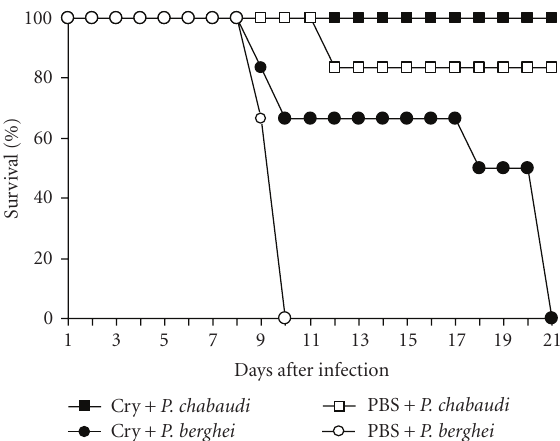
Figure 2: E ff ect of Cry1Ac on the survival of Plasmodium -infected mice. Cry1Ac pretreated mice ( n = 8) were infected with P. chabaudi AS or P. berghei ANKA. Survival was recorded until day 21 PI, at which time all of the P. berghei ANKA-infected mice had died. Data are representative of two separate